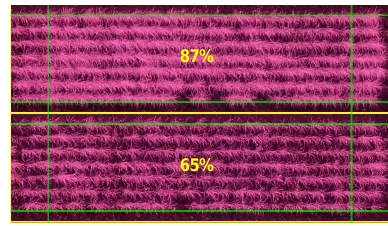
Figure 8: Differences in leaf area ’cover’ of two plots of wheat estimated from processed NIR images acquired by the